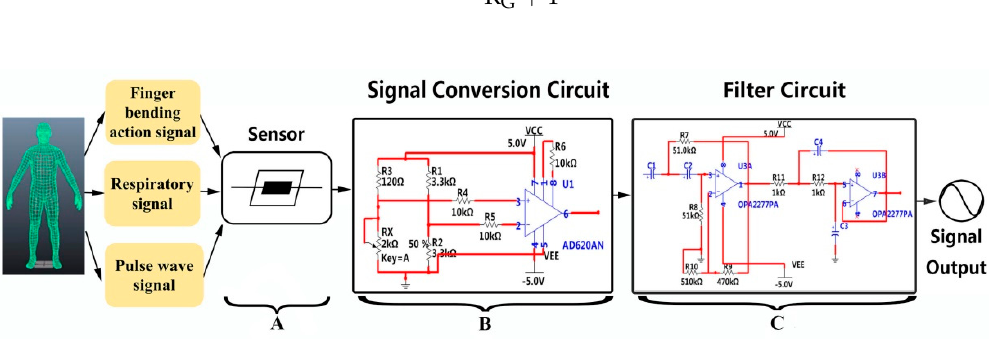
Figure 4. Schematic of sensing and measurement circuits. Part A is the graphene sensor. Part B is the signal conversion circuit. Part C is the filter circuit.